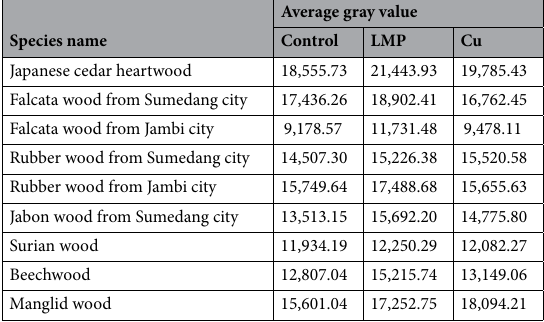
Table 3. Average gray value differences of all hardwood, softwood, and non-wood